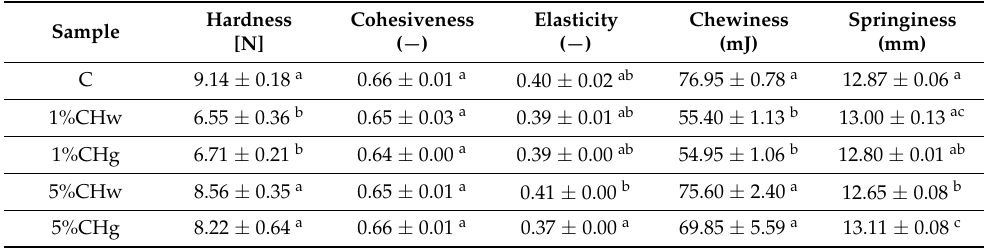
Table 5. Texture parameters of wheat bread without and with the addition of chia seeds (TPA test).